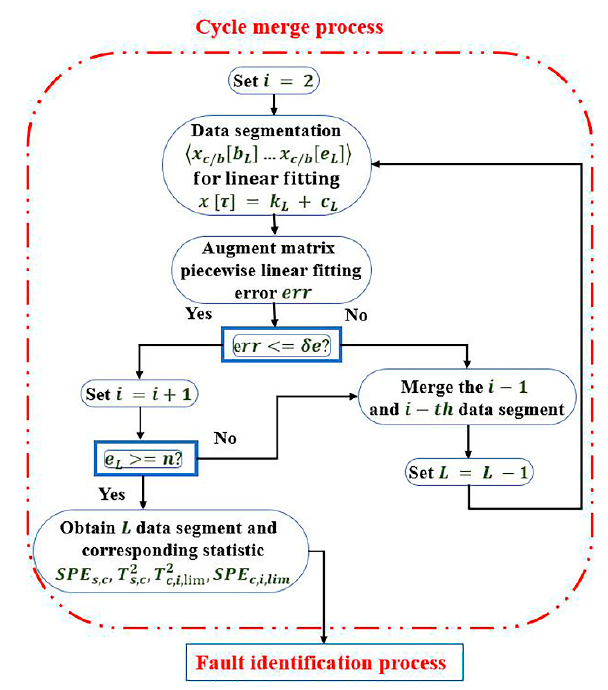
Figure 5. Cycle merge process of fault detection.